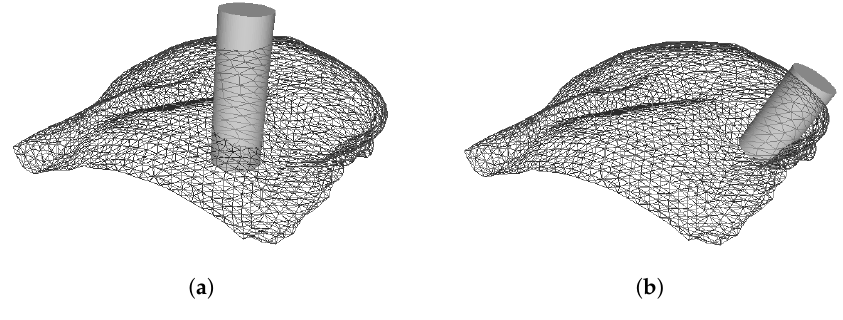
Figure 6. Alignment of a predefined cylinder ( a ) through the direction given by pectoral normal; in relation to the tumor location ( b ).